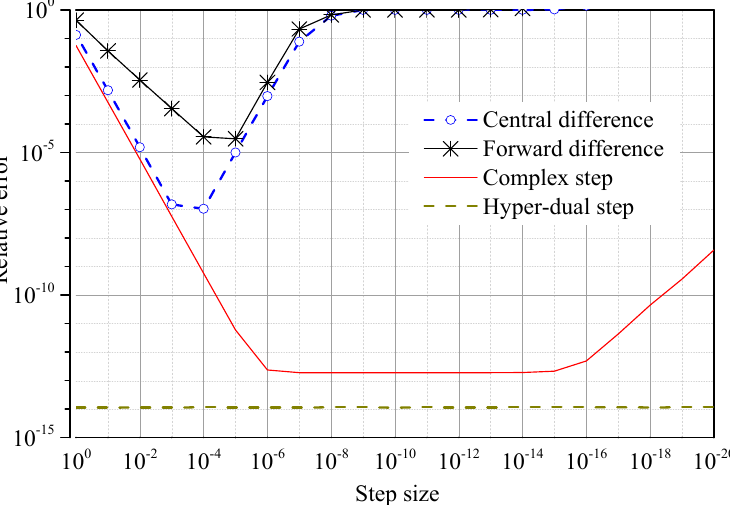
Figure 6. The first derivative of the nonlinear stiffness matrix ∂ K / ∂ q 1 —errors of numerical methods. Figure 6. The fi rst derivative of the nonlinear sti ff ness matrix 1 q ods.